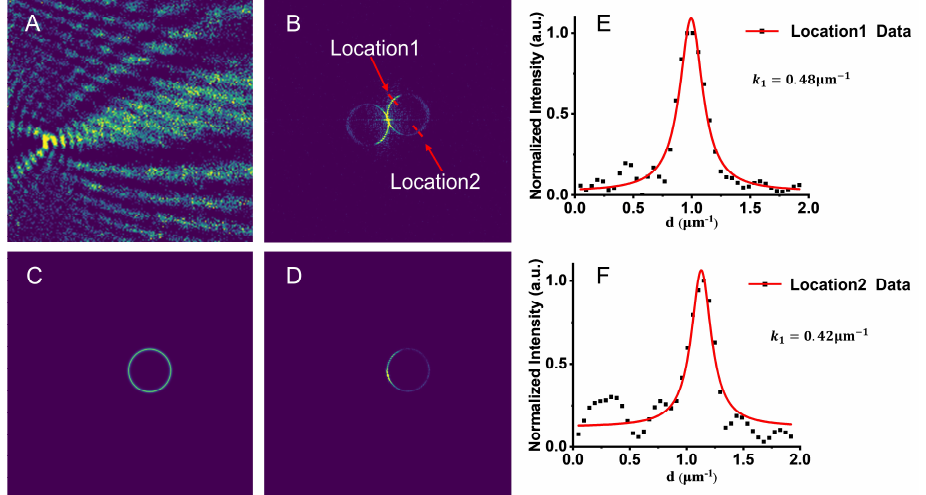
Figure 5. Original SPRM image of a single 200 nm polystyrene nanosphere and its filter in frequency domain. ( A ) SPRM image of a single 200 nm polystyrene nanosphere; ( B ) two ‐ dimensional Fourier transform of ( A ); ( C ) ring filter; ( D ) the spectrum obtained by applying the ring filter ( C ) to ( B ); ( E,F ) intensity curves along the red dotted line at the Location 1 and Location 2 on the right ring in ( B ); d represents the spatial frequency.